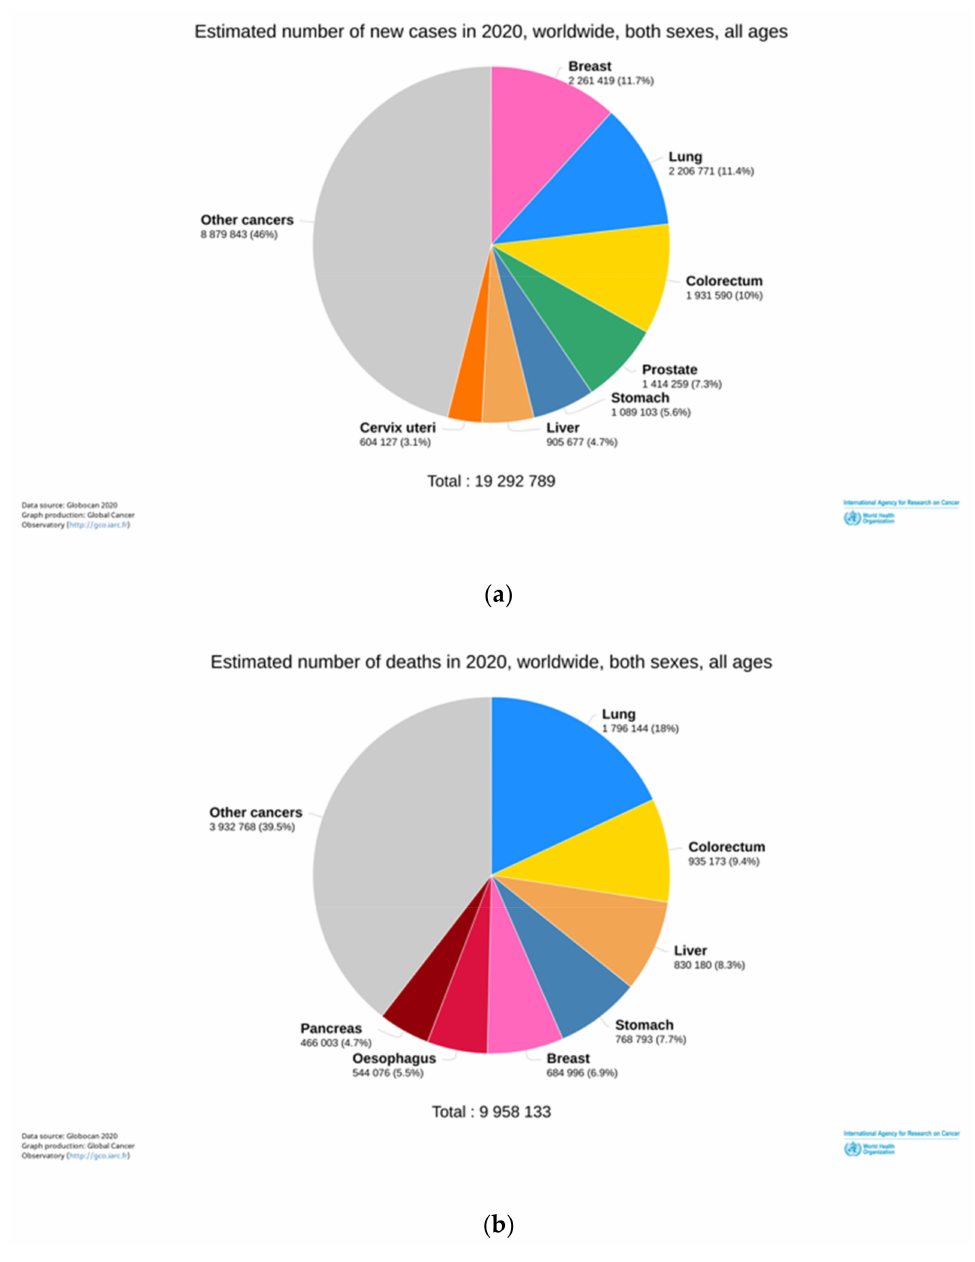
Figure 1. New cases and deaths estimated worldwide in both sexes and all ages related to cancer [1]. ( a ) Estimate number of new cases. ( b ) Estimate number of deaths. Data Source: GLOBOCAN 2020. Graph Production: International Agency for Research on Cancer (IARC) (https://gco.iarc.fr/today/ home), World Health Organization. It was accessed on 19 June